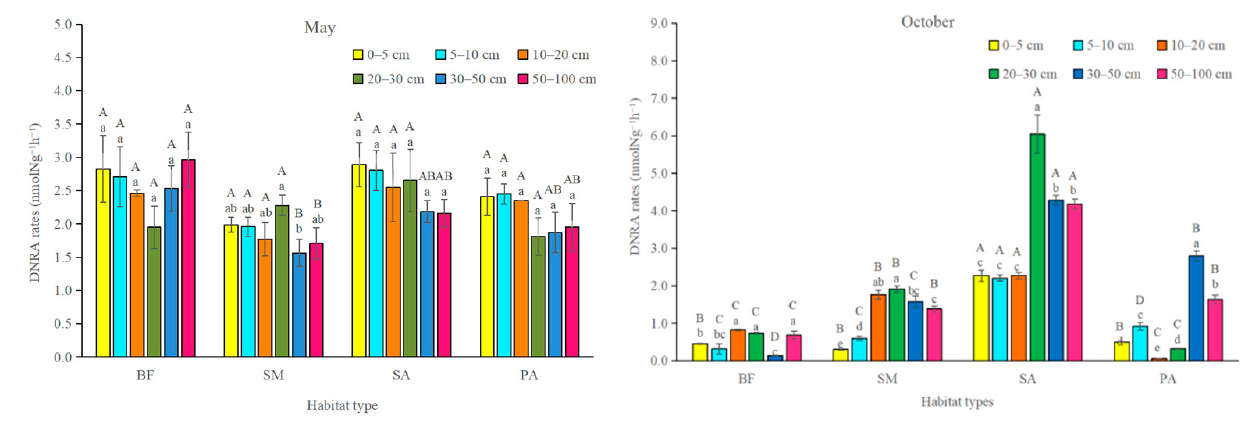
Figure 2. Potential rates of dissimilatory nitrate reduction to ammonium (DNRA). Bars represent standard errors of the quadruplicate samples. SM: S. mariqueter ; SA: S. alterniflora ; PA: P. australis ; BF: bare mudflat. Bars with different uppercase letters and lowercase letters denote significantly different in habitat types and soil depths, respectively ( p < 0.05).